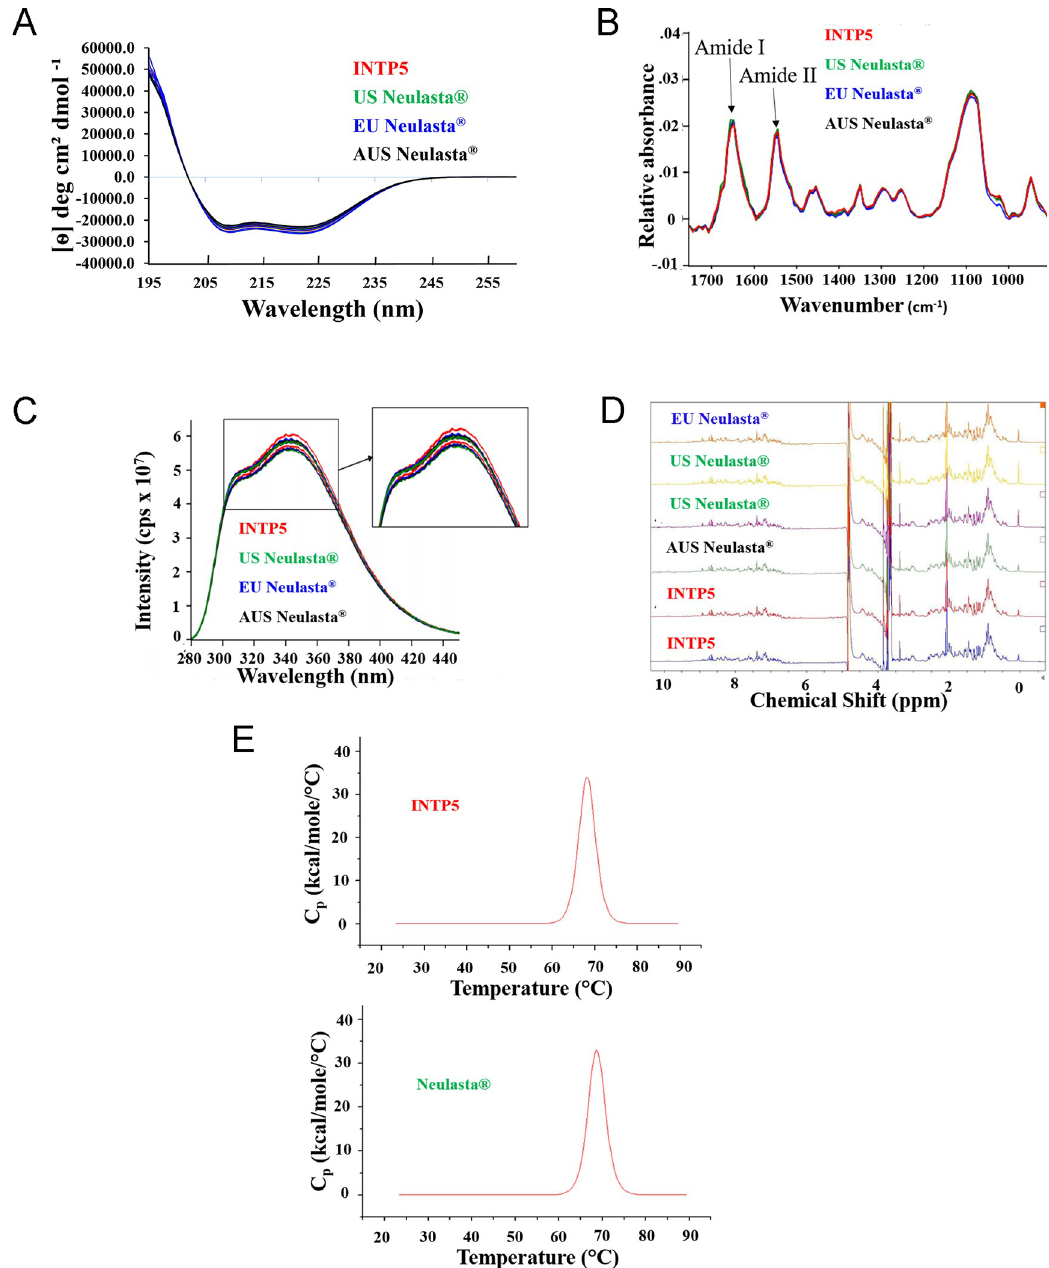
Fig 2. (A) Overlay of far UV CD spectra, (B) Overlay of FTIR spectra, (C) Overlay of fluorescence spectra, (D) overlay of 1D NMR spectra and (E) DSC thermogram of INTP5 and